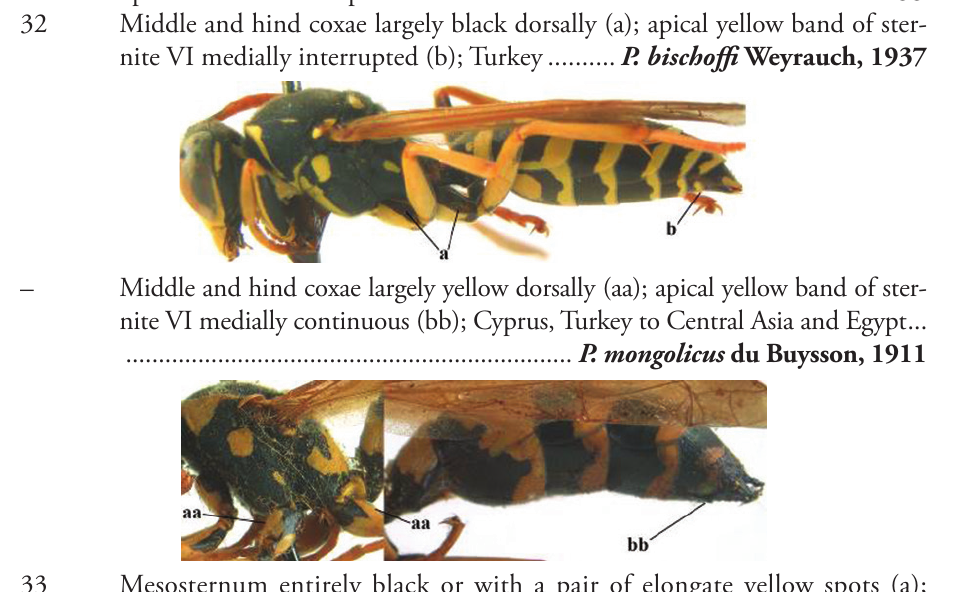
Middle and hind coxae largely black dorsally (a); apical yellow band of ster-